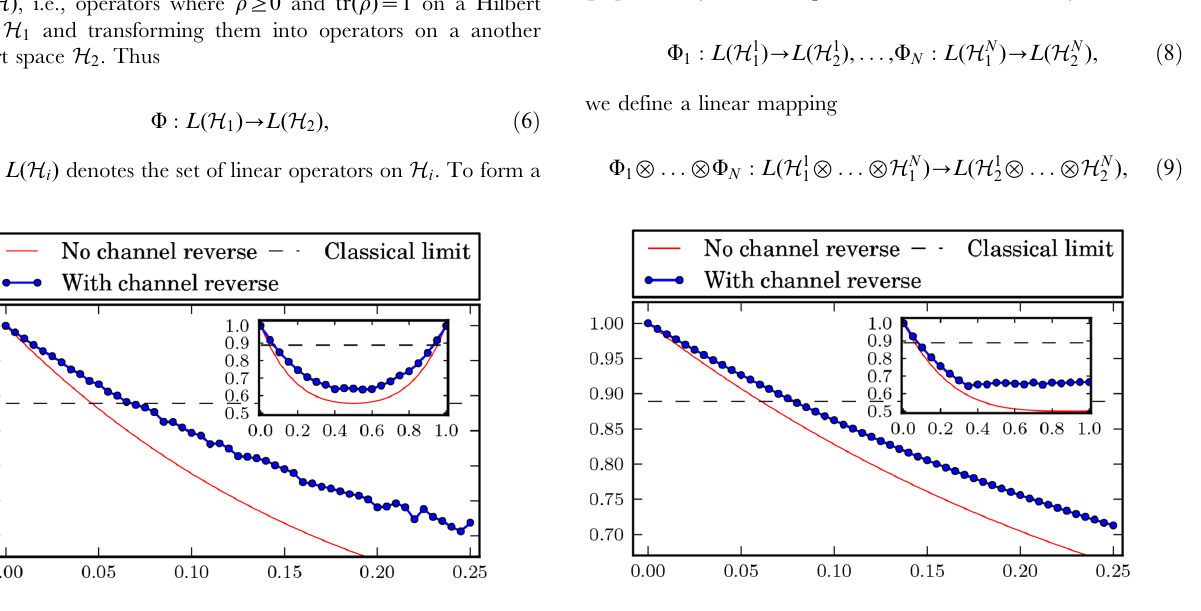
Figure 2. Bit flip channel. Probability of winning the pseudo- telepathy game with and without the use of our approach as a function of the noise parameter a for the bit flip channel. The inset shows the probability of winning for a M [0; 1].